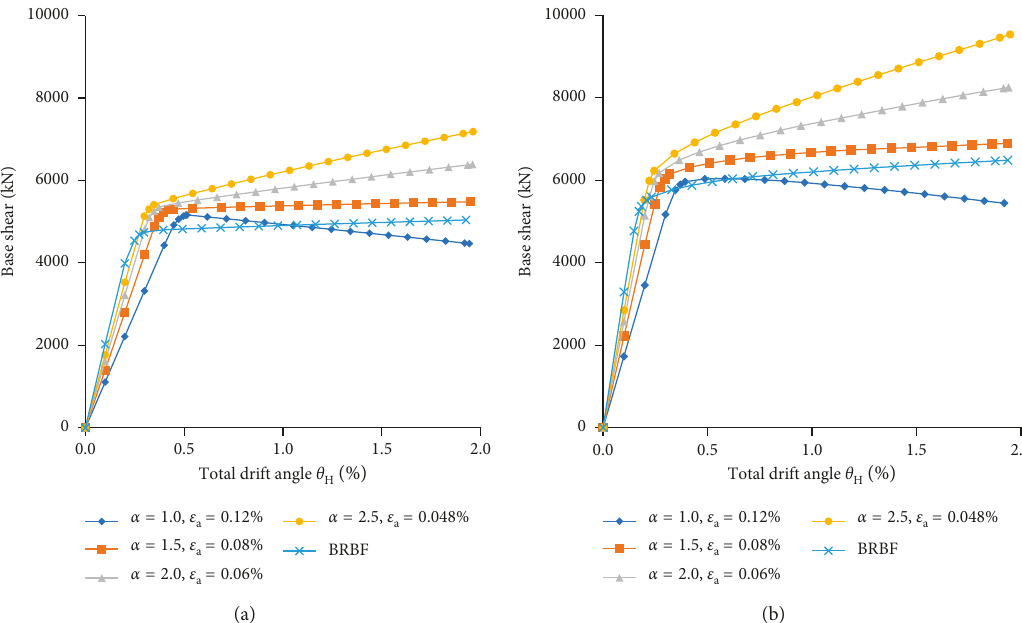
Figure 25: The effects of ε and α on the base shear response of 16-story SC-TOBFs. (a) LD-1. (b) LD-2. a